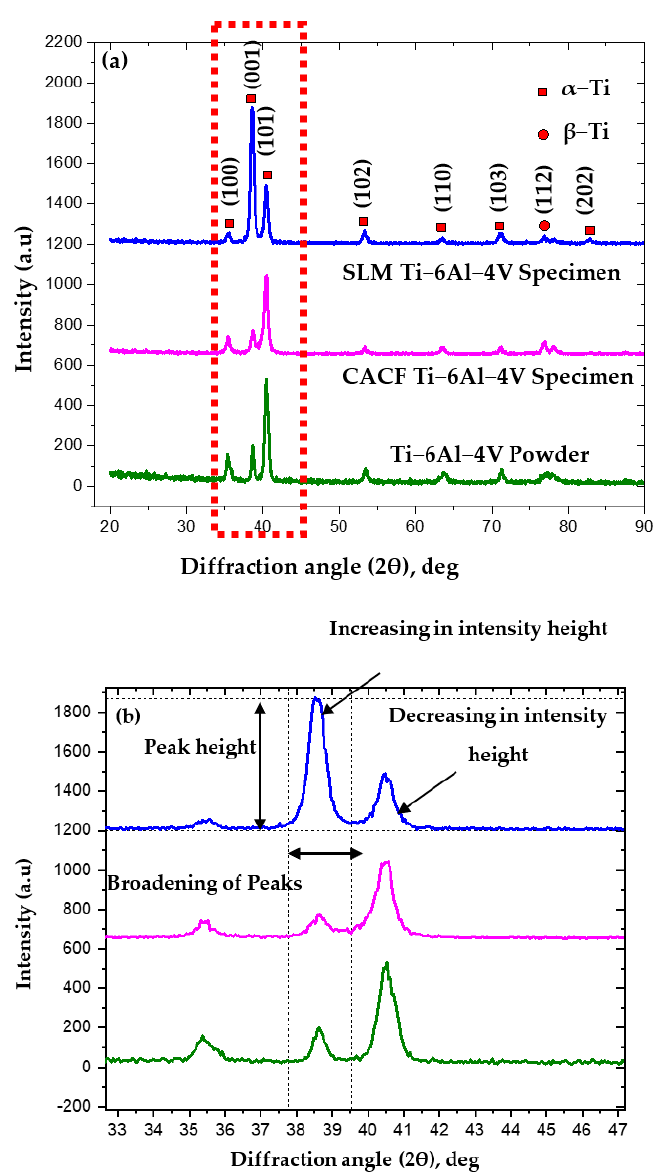
Figure 1. ( a ) XRD pattern of gas-atomized powder, CACF specimen, and SLM specimen, and ( b ) magnified view of ( a ).